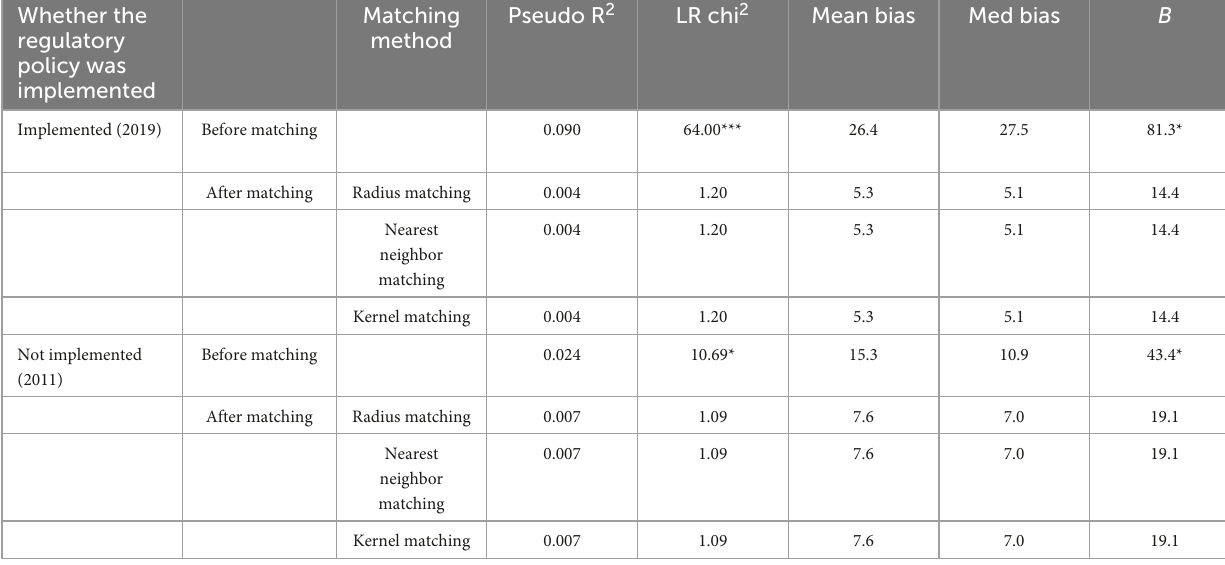
TABLE 4 Balance test of matching quality.